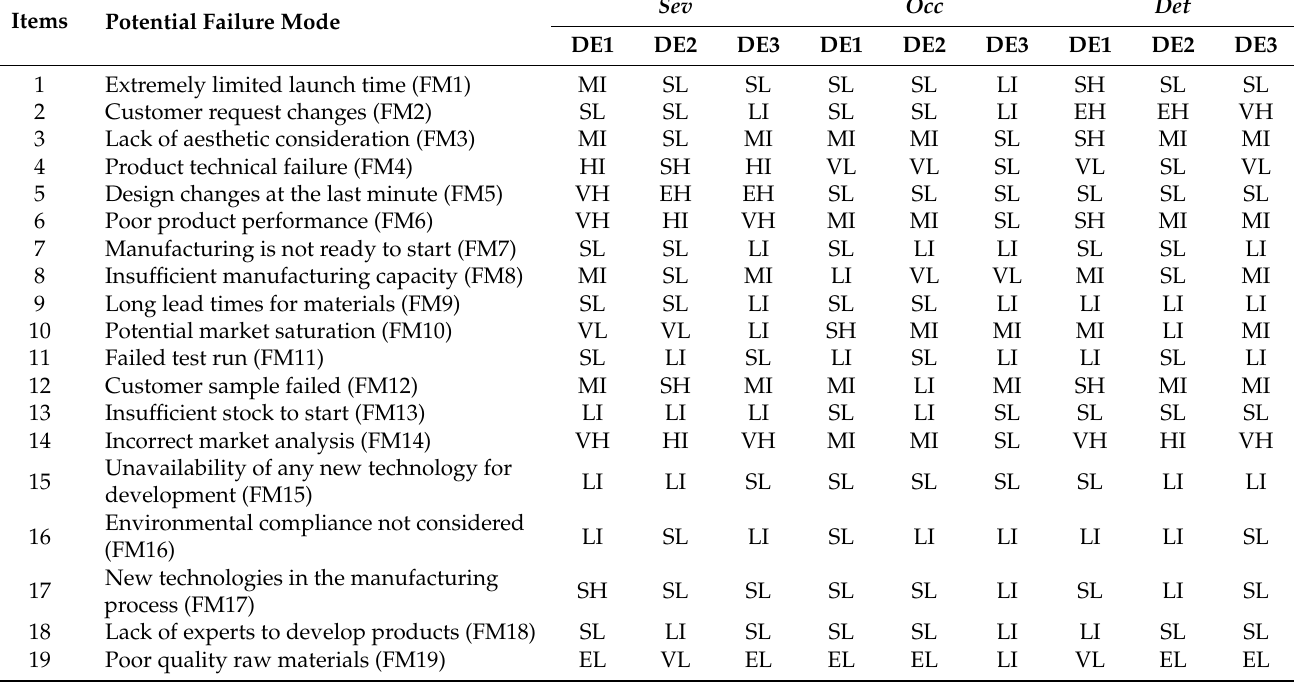
Table 2. Linguistic values of potential failure items given by experts. (FM: failure